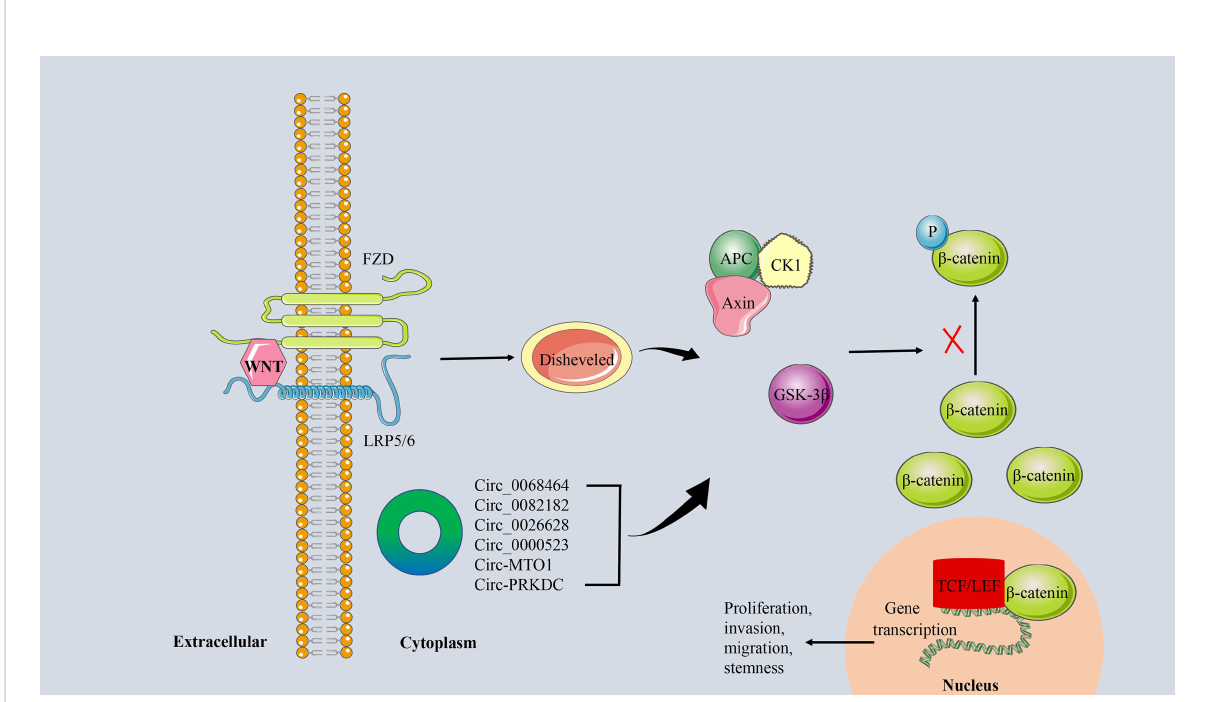
FIGURE 8 The circRNA/WNT/ b − catenin signaling axis in CRC. The linking of WNT protein to the FZD-LRP5/6 receptor complex activates the downstream protein Disheveled. It further promoted the dissociation of GSK-3 b from Axin, which inhibited the phosphorylation of b -catenin. Unphosphorylated b -catenin is transferred to the nucleus and binds to the transcription factor TCF/LEF to induce transcription of the target